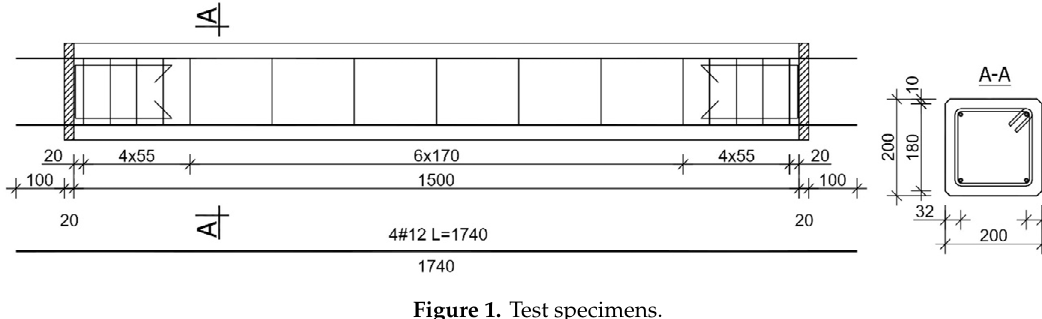
Figure 1. Test Figure 1. Test specimens.